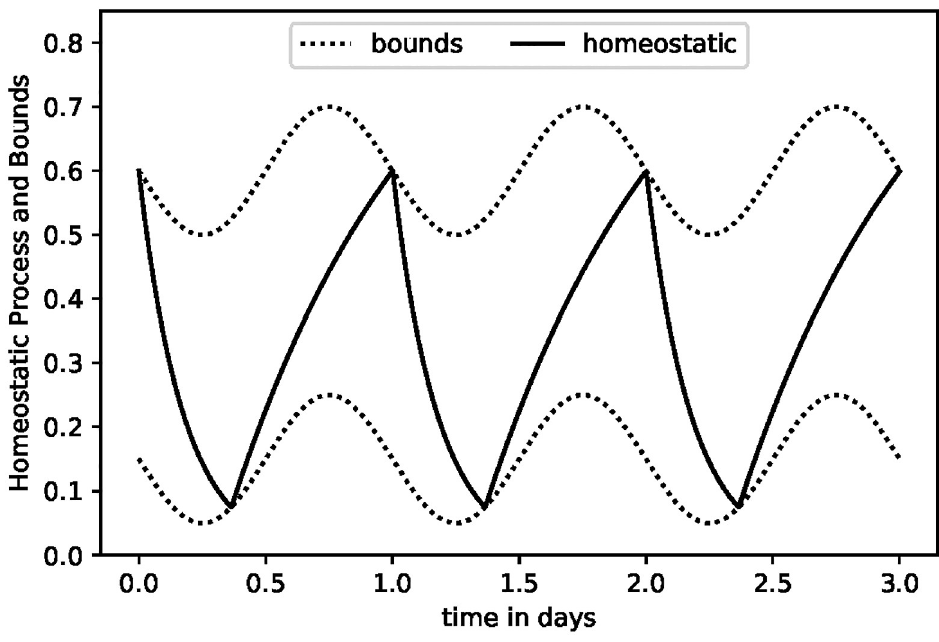
Fig 1. Two-process